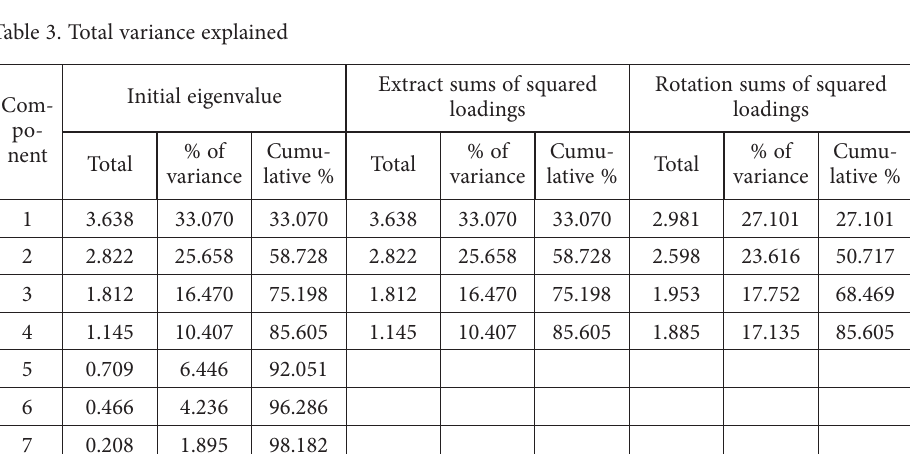
Table 3. Total variance